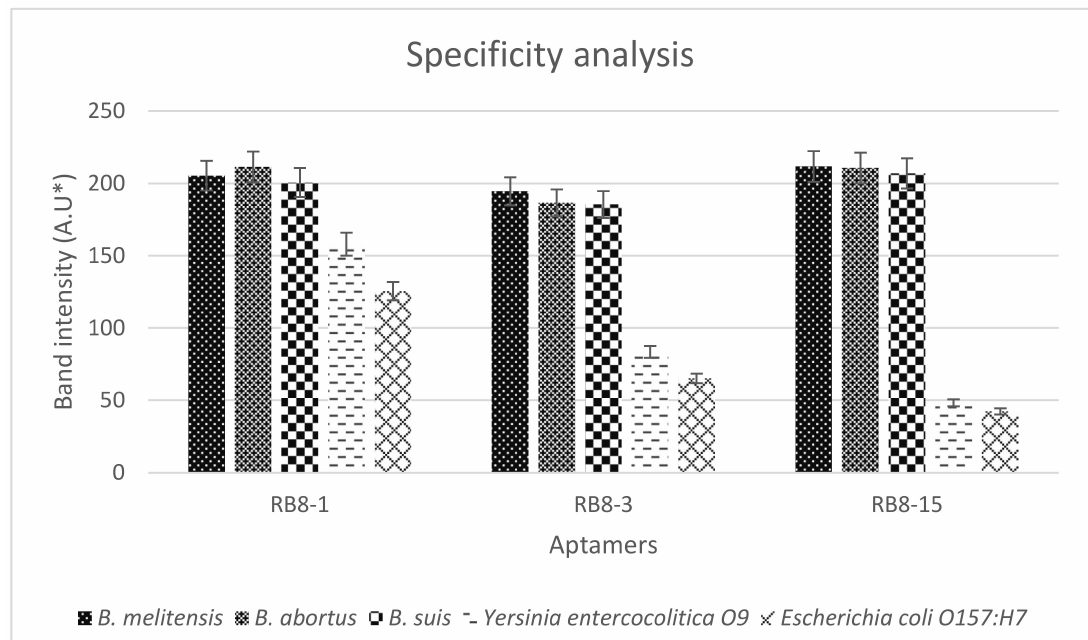
Figure 3. Specificity analysis of RB8-1, RB8-3, and RB8-15 for B. melitensis, B. abortus, B. suis, Yersinia entercocolitica O9, and Escherichia coli O157:H7. * A.U = arbitrary